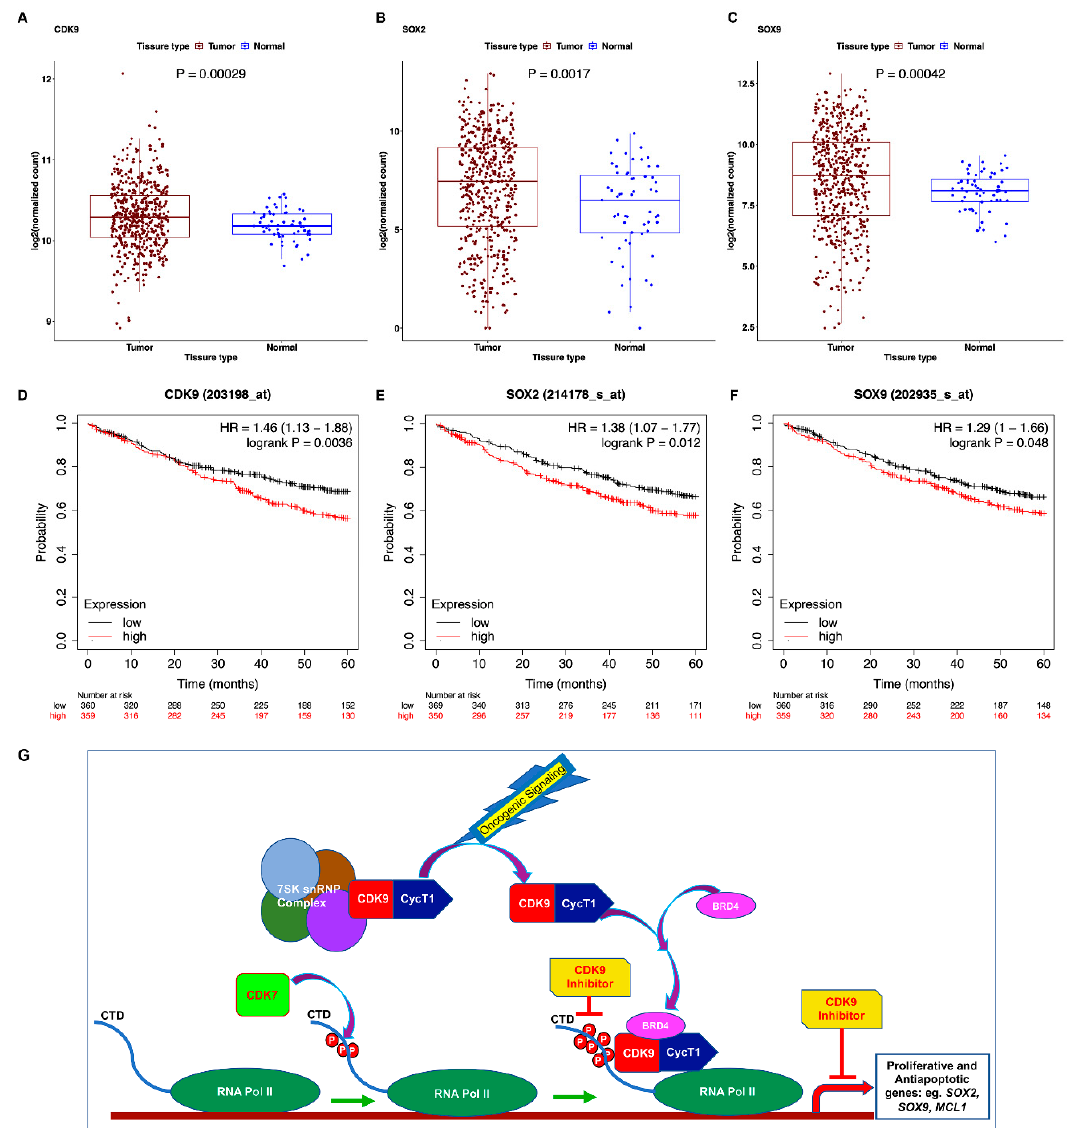
Figure 8. Lung adenocarcinomas show increased expression of CDK9, SOX2, and SOX9: ( A – C ) RNAseq dataset from TCGA FireBrowse portal show significantly high expression of CDK9, SOX2, and SOX9 in lung tumor samples compared to normal tissues. ( D – F ) Five-year survival curves generated from KM plotter show that high expression of CDK9, SOX2, and SOX9 correlate with poor overall survival in lung adenocarcinoma patients. ( G ) Schematic showing the potential mode of action of CDK9 inhibitors to prevent tumor growth. Cyclin T/CDK9 in response to oncogenic signaling leads to its association with BRD4 and recruitment to target promoters. This results in phosphorylation of RNA Pol II CTD, and active transcription of oncogenic genes. Inhibitors targeting CDK9 will interfere with Pol II CTD phosphorylation and active transcription of genes to prevent tumor growth.